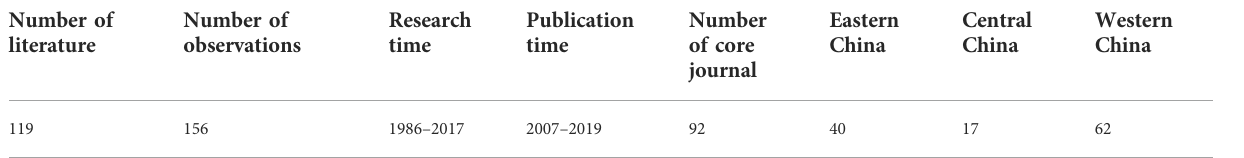
TABLE 1 Information about literature included in the value transfer